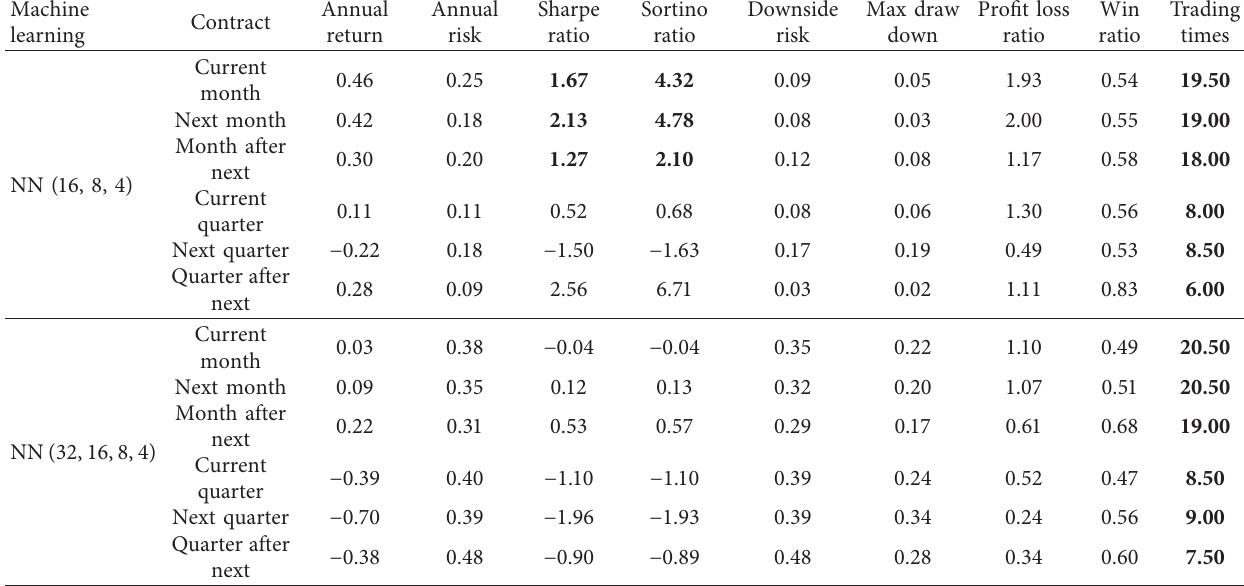
Table 14: Option strategy of predicting the rise and fall of volatility by threshold (use 30 features M4, threshold � 0.5). Machine